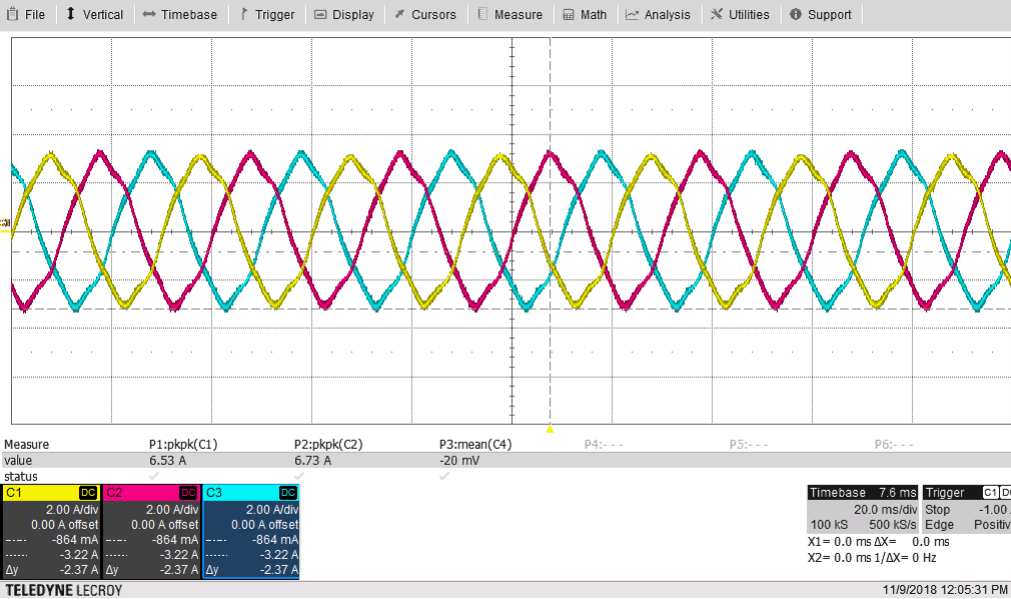
Figure 9. Motor currents at 500